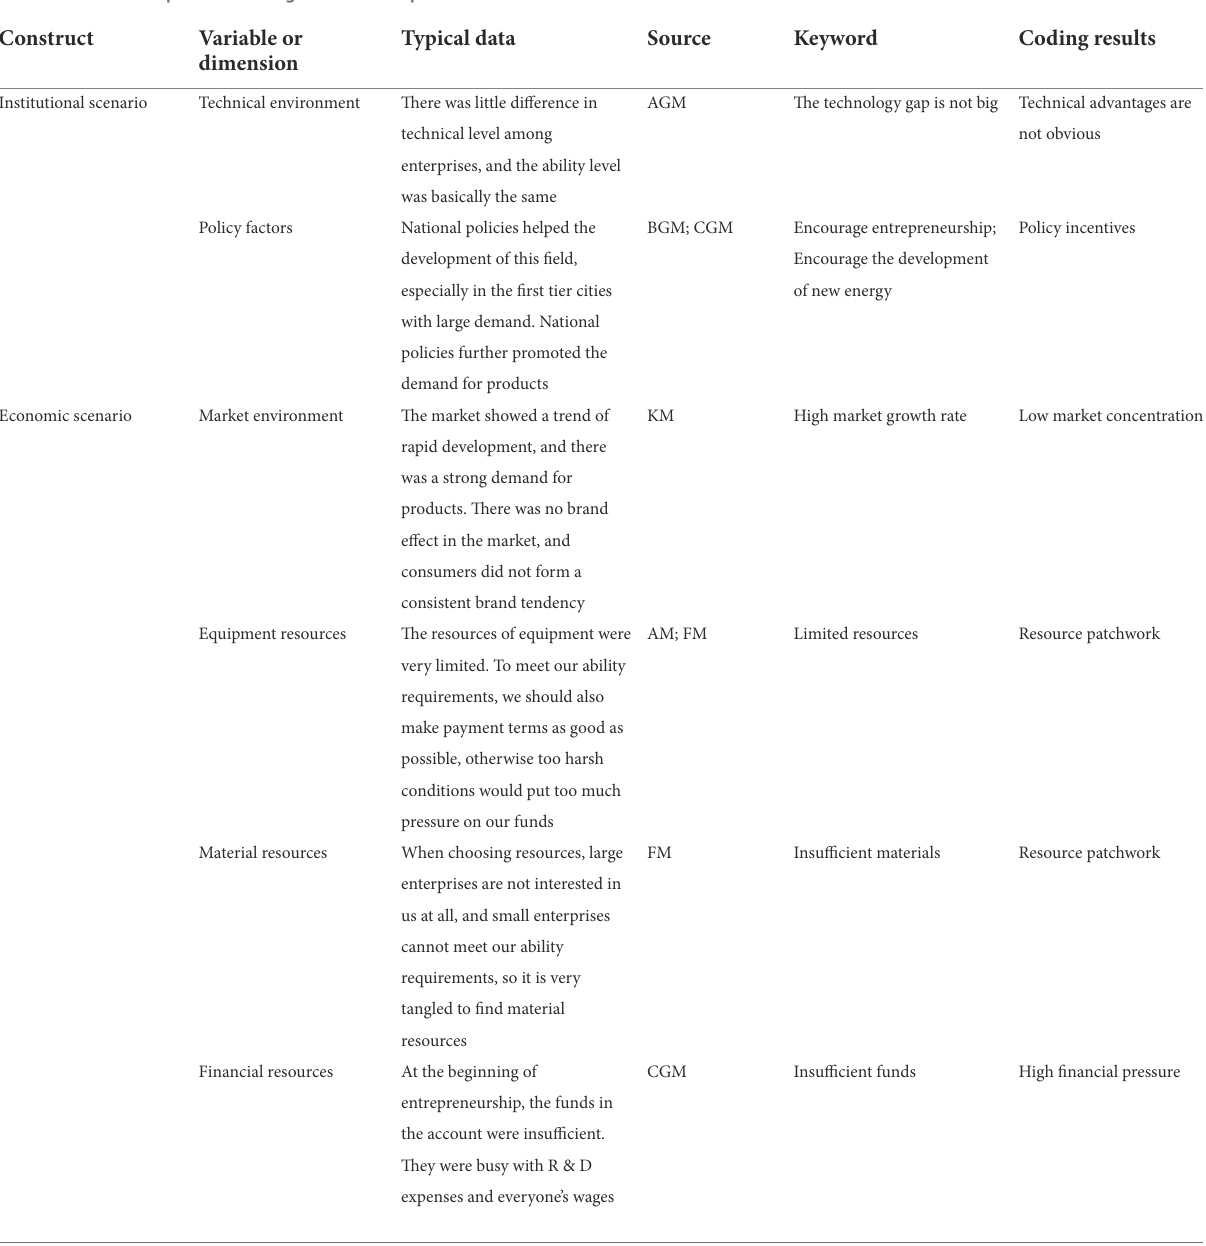
TABLE 5 Cited examples and coding results at the phase